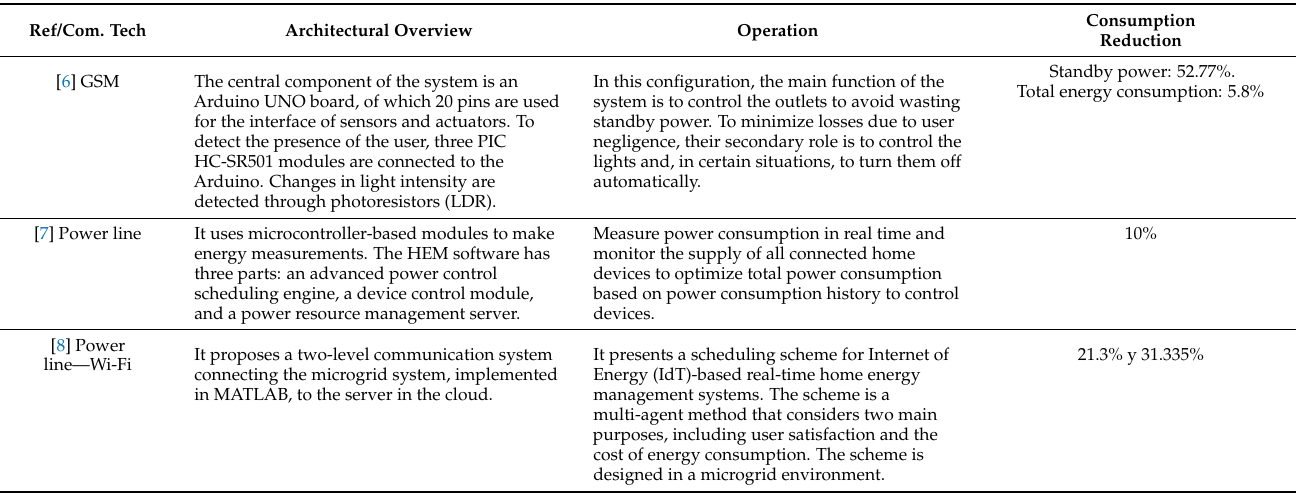
Table 1. Comparative study of HEM systems in the last 5